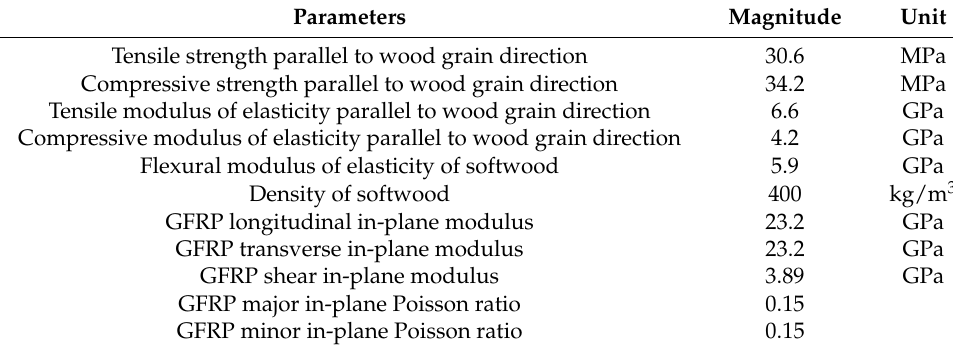
Table 2. Material properties of softwood timber and GFRP adapted from [45] © 2023 Elsevier Ltd. Parameters Magnitude Unit Tensile strength parallel to wood grain direction Tensile modulus of elasticity parallel to wood grain direction Compressive modulus of elasticity parallel to wood grain direction Flexural modulus of elasticity of